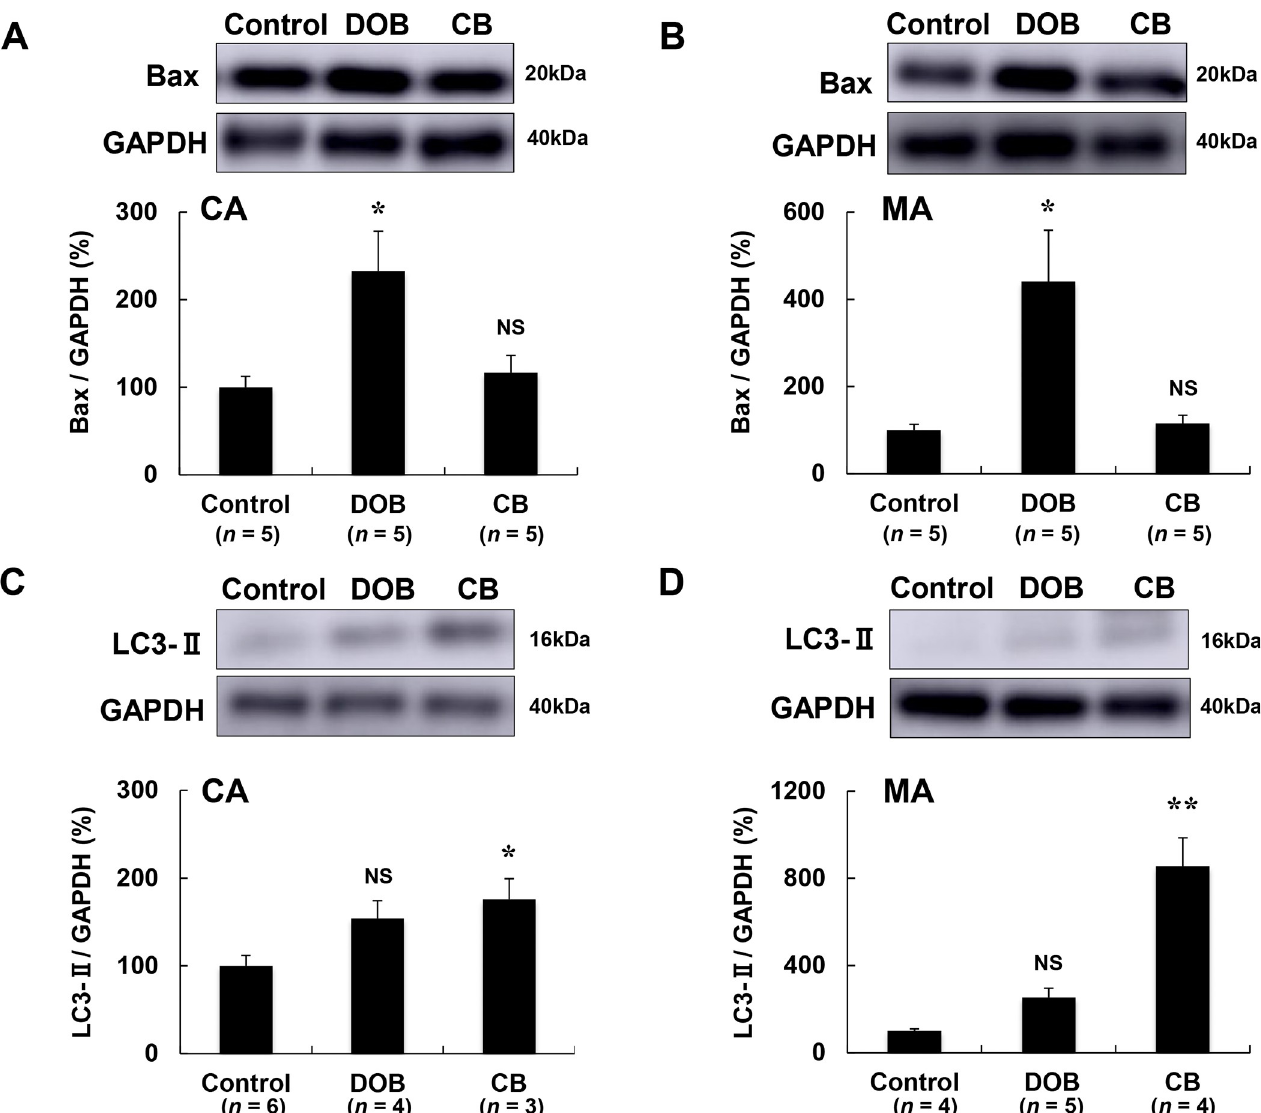
Fig 5. Effects of DOB and CB on expression of BAX and LC3 in cardiac and masseter muscles. (A-B) BAX expression was significantly increased in the DOB group, but not in the CB group, in both cardiac (A) and masseter (B) muscles ( � P < 0.05 each vs. Control). (C-D) LC3-II expression was significantly increased in the CB group, but not in the DOB group, in both cardiac (C) and masseter muscles (D) ( � P < 0.05 or �� P < 0.01 each vs. Control). MA; masseter muscle.